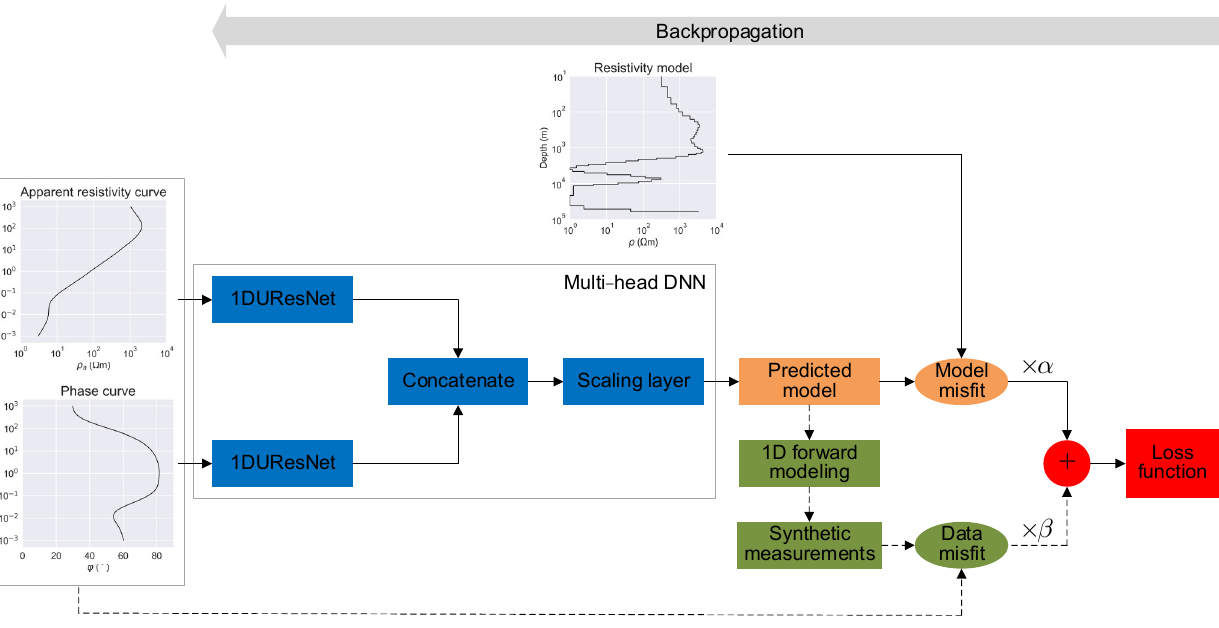
Figure 3. An overview of the proposed physics−driven DL (PhyDNN) inversion scheme for MT.